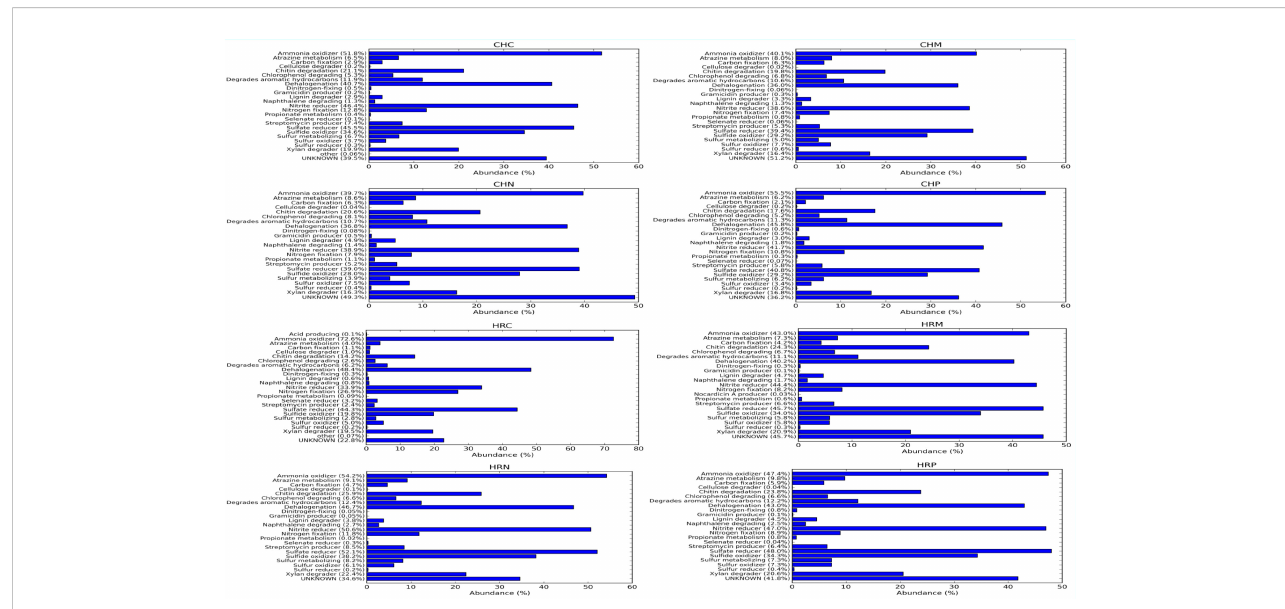
FIGURE 5 Metabolic functional annotation and amplitude of metabolic pathways governed by native bacterial diversity among treatment and control under different